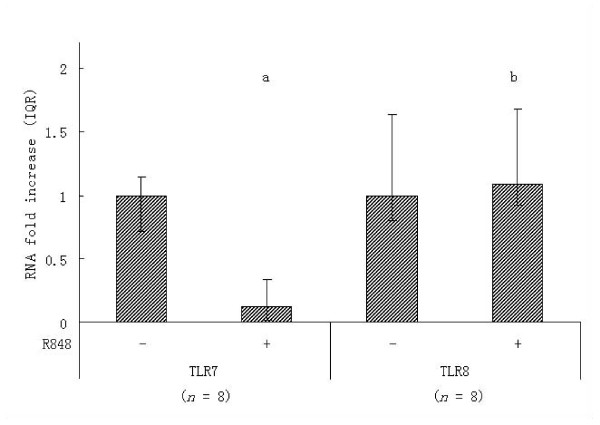
R-848 alters Toll-like receptor expression in vitro. Freshly isolated monocytes from uninfected (n = 3) and HIV-infected (n = 5) subjects were cultured in the presence of R-848 or media alone for 24 h. TLR7/8 mRNA then quantified using real-time PCR. R-848 stimulation significantly decreased expression of TLR7 in monocytes (ap = 0.025) but did not alter TLR8 expression (bp = 0.944). Data was analyzed using the Wilcoxon signed ranks test. Bars indicate the interquartile range (IQR).